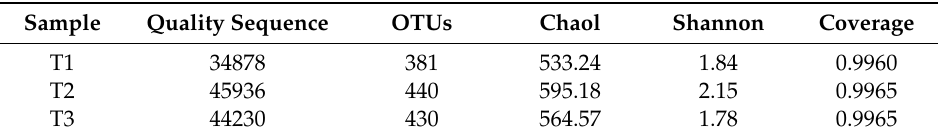
Table 4. Correlation index of the alpha diversity of the sludge